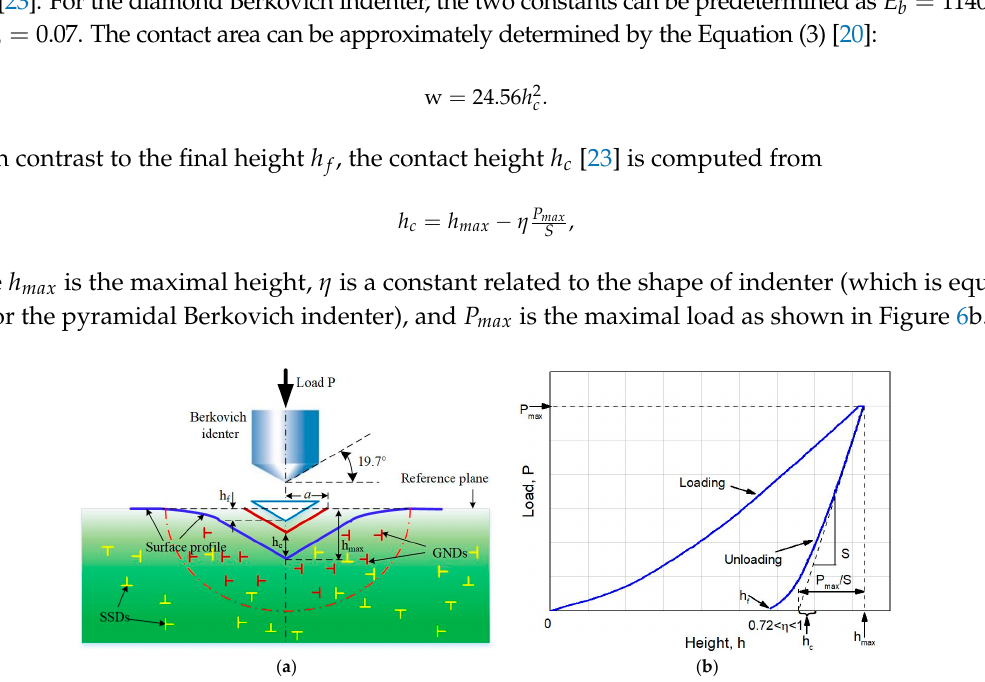
Figure 5. Variations of fraction of recrystallized grains in samples A and B with respect to holding time.